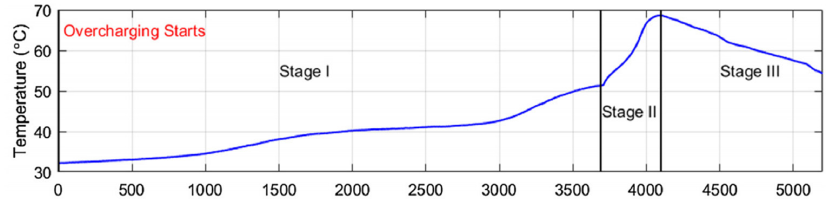
Figure 12. Thermal runaway stages. The three stages of battery surface temperature under overcharge thermal runaway: (I) Stage I—normal heat-accumulating stage; (II) stage II—fast heat-accumulating stage; (III) stage III—heat dissipation stage after severe thermal runaway [81].